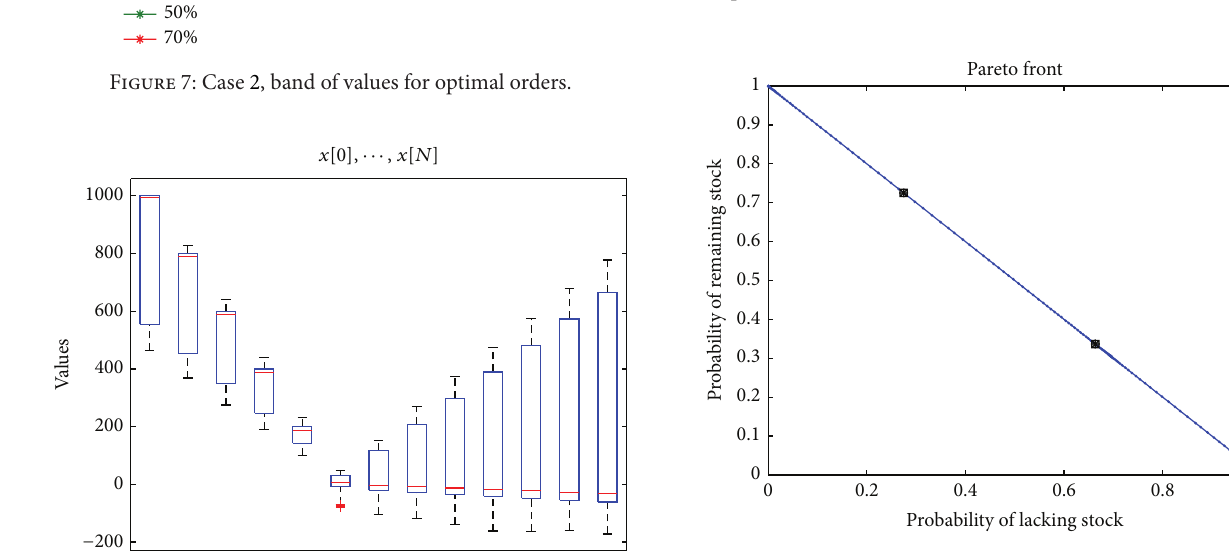
Figure 9: Case 2, box-plots for inventory levels when ordering by 70th percentile.